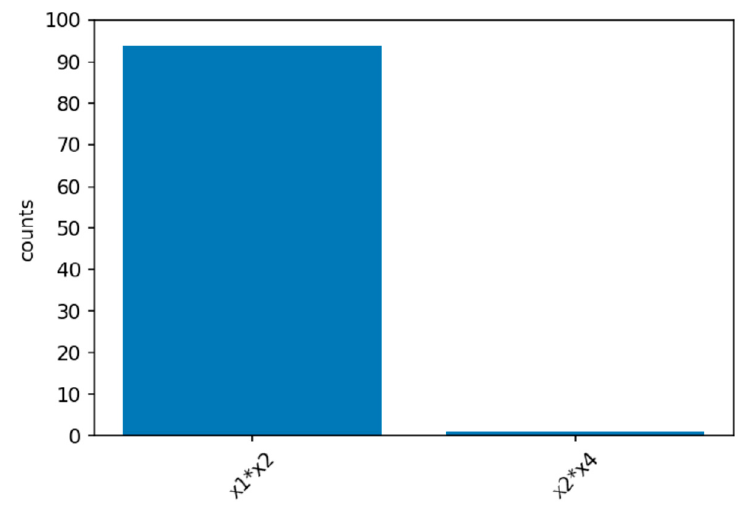
Figure 5. Power simulation under the moderate interaction effect of normal (1, 1) for XGB-FI.